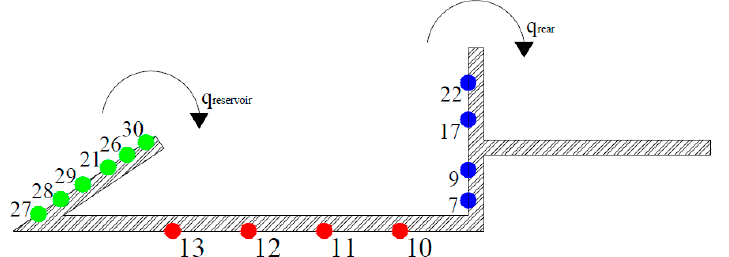
Figure 4. The positions of the water gauges to evaluate (1) the pressure acting on the device and (2) the q reservoir and q rear .